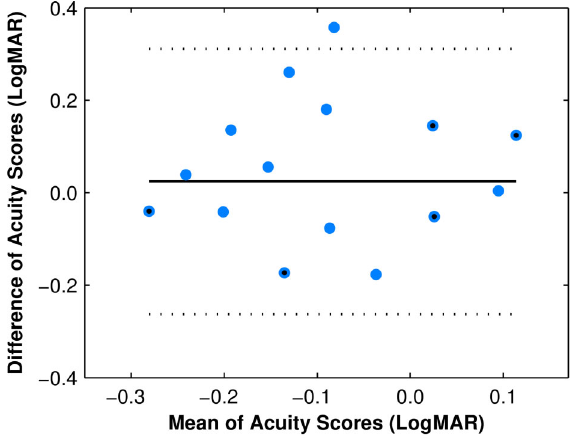
Figure 9. Validation analysis. Bland-Altman plot of the differences in visual acuity scores between our letter recognition task and the Snellen chart test. The vertical axis displays the difference between measurements on both tasks, and the horizontal axis displays the mean acuity score value between the tasks. The solid line is the mean difference in LogMAR acuity ( 2 0.02), and the area within the dotted lines represents the limits of agreement between LogMAR scores in the two visual acuity tasks. Each point represents the results from a single subject (blue circles), although some are overlapped (blue circles with black